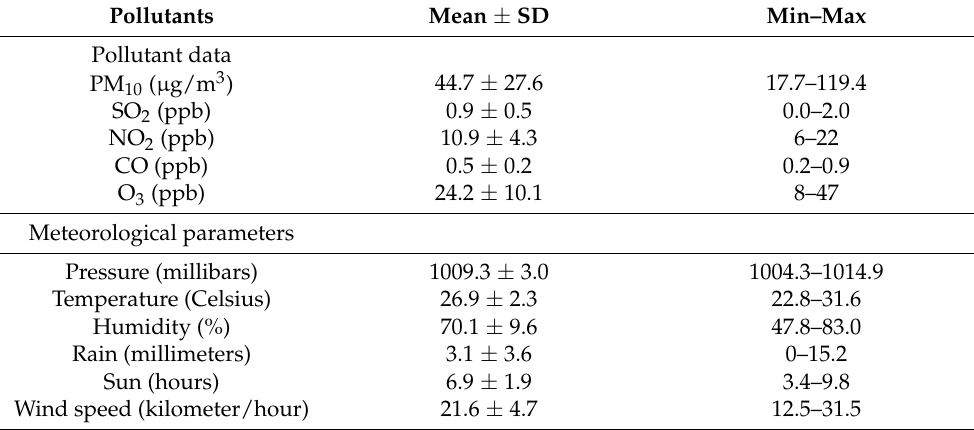
Table 1. Monthly Average of All Pollutants Data and Meteorological Parameters (from January 2010 to April 2013).